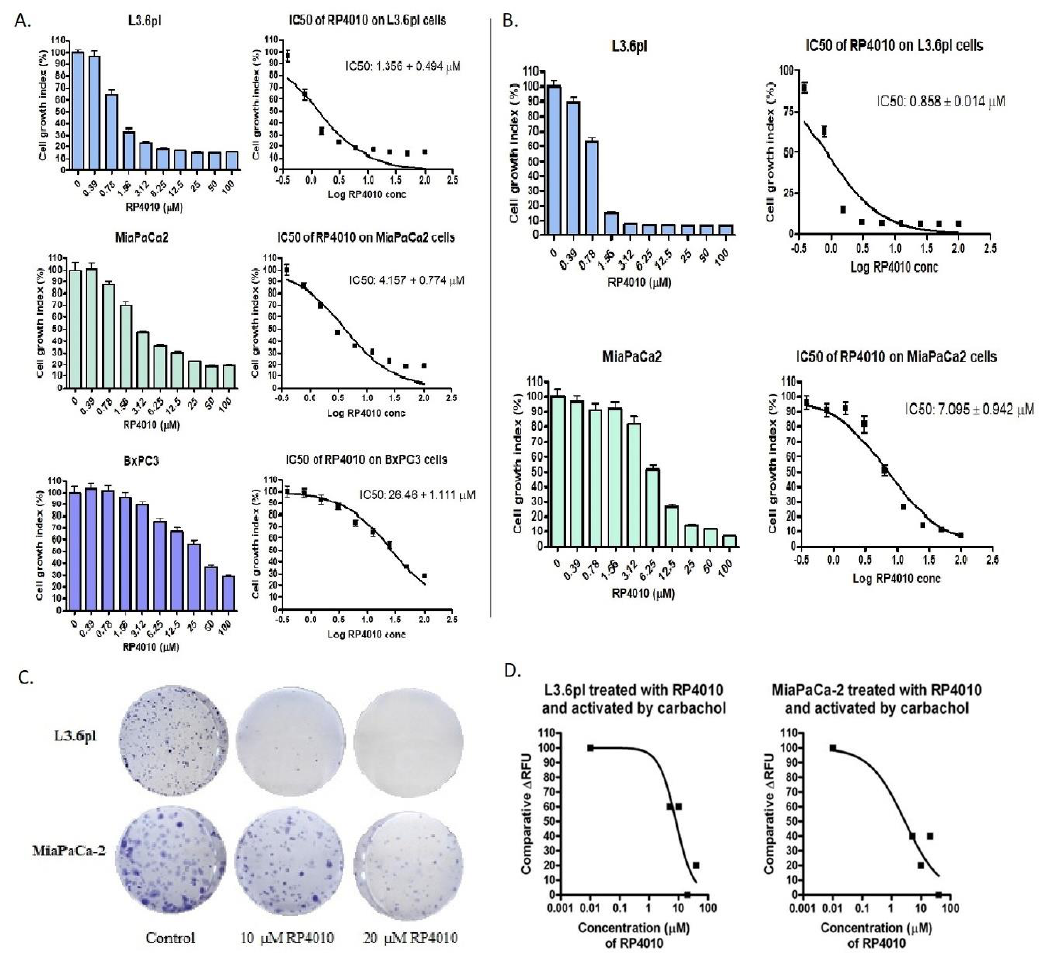
Figure 1. RP4010 suppressed the proliferation of pancreatic cancer cells and inhibited carbachol-induced calcium influx in pancreatic cancer cells. L3.6pl, MiaPaCa-2, and BxPC-3 cells were treated with the indicated concentrations of RP4010 for 72 h. Cell proliferation inhibition was evaluated using MTT assay ( A ) and BrdU assay ( B ), as described in Methods, and average values from three independent experiments were plotted ( n = 3). Images showing Coomassie Blue stained colonies formed by L3.6pl and MiaPaCa-2 cells ( C ) after treatment with RP4010 at the indicated concentrations ( n = 3). ( D ) Calcium influx assay was performed as described in Methods, and the relative fluorescence units were plotted for L3.6pl and MiaPaCa-2 cells treated with various concentrations of RP4010 ( n = 1).